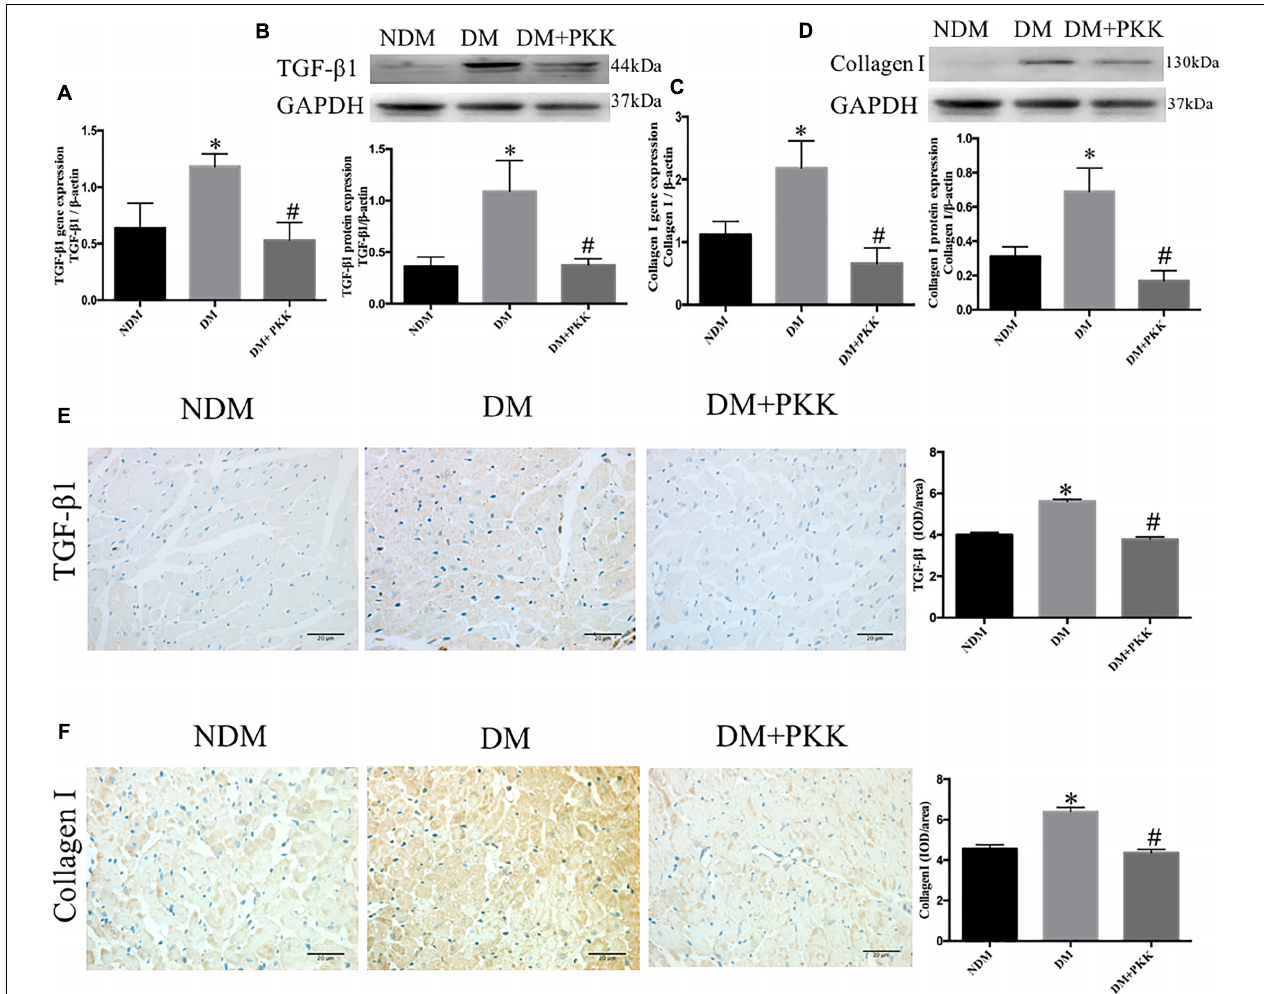
FIGURE 4 | Pancreatic kallikrein administration reduced the expression of transforming growth factor β 1 and collagen I in DCM. (A) The mRNA expression of TGF- β 1. (B) The protein expression and quantitation of TGF- β 1 using western blot. (C) The gene expression of collagen I. (D) The protein expression and quantitation of collagen I using western blot. (E,F) Representative IHC micrographs of cardiac tissue stained with TGF- β 1 and collagen I for the NDM, DM, and DM + PKK groups (original magnification × 40). The IHC quantitative data of heart sections for TGF- β 1 and collagen I staining are summarized. Each sample for qPCR and western blot was repeated for three times. Values are mean ± SEM, n = 6 per group; ∗ P < 0.05 vs. NDM group; # P < 0.05 vs. DM + PKK